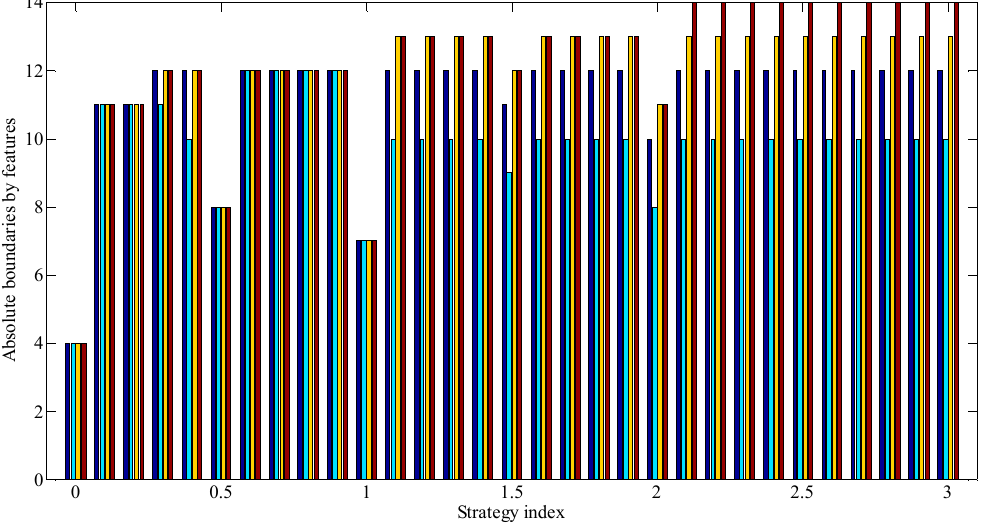
Figure 11. Diagram for absolute boundaries of classes by assessment features in groups of rules.